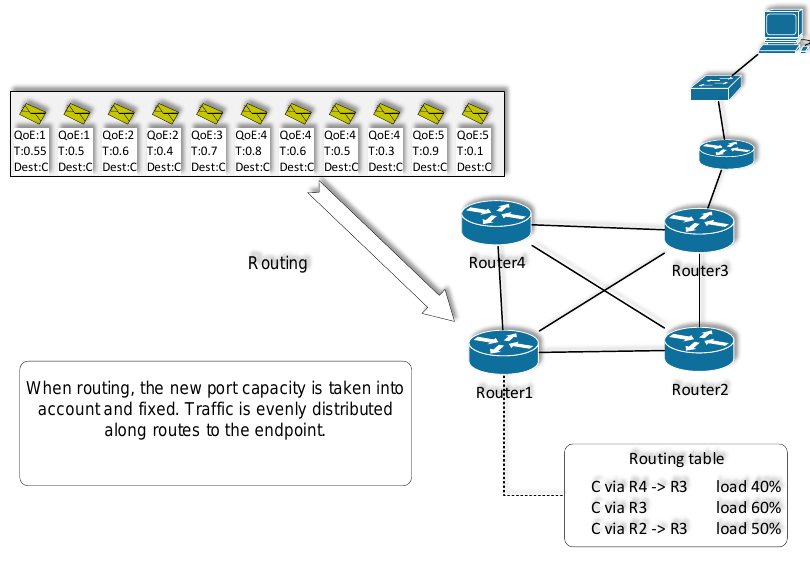
Figure 16. The network load balancing technique.